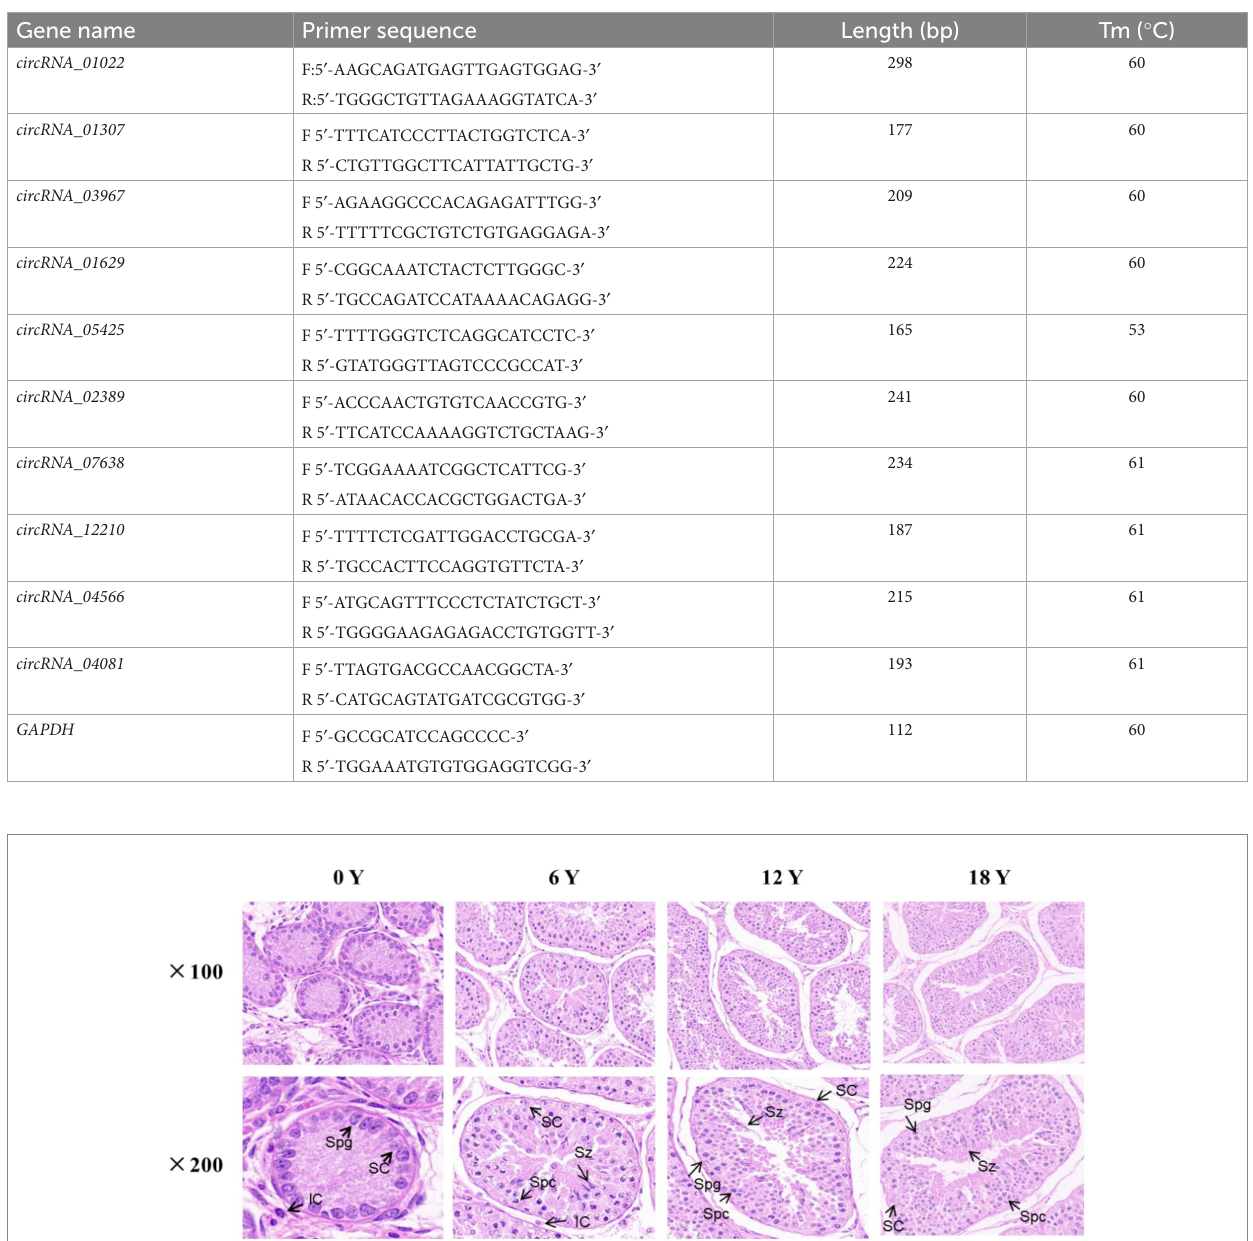
TABLE 1 RT-qPCR primer information.